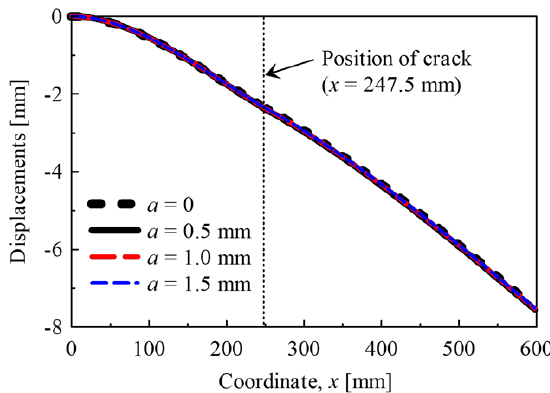
change in the z -direction due to loading. Figure 4. The z -displacement of the upper surface of Model 2D. The z -displacement implies the change